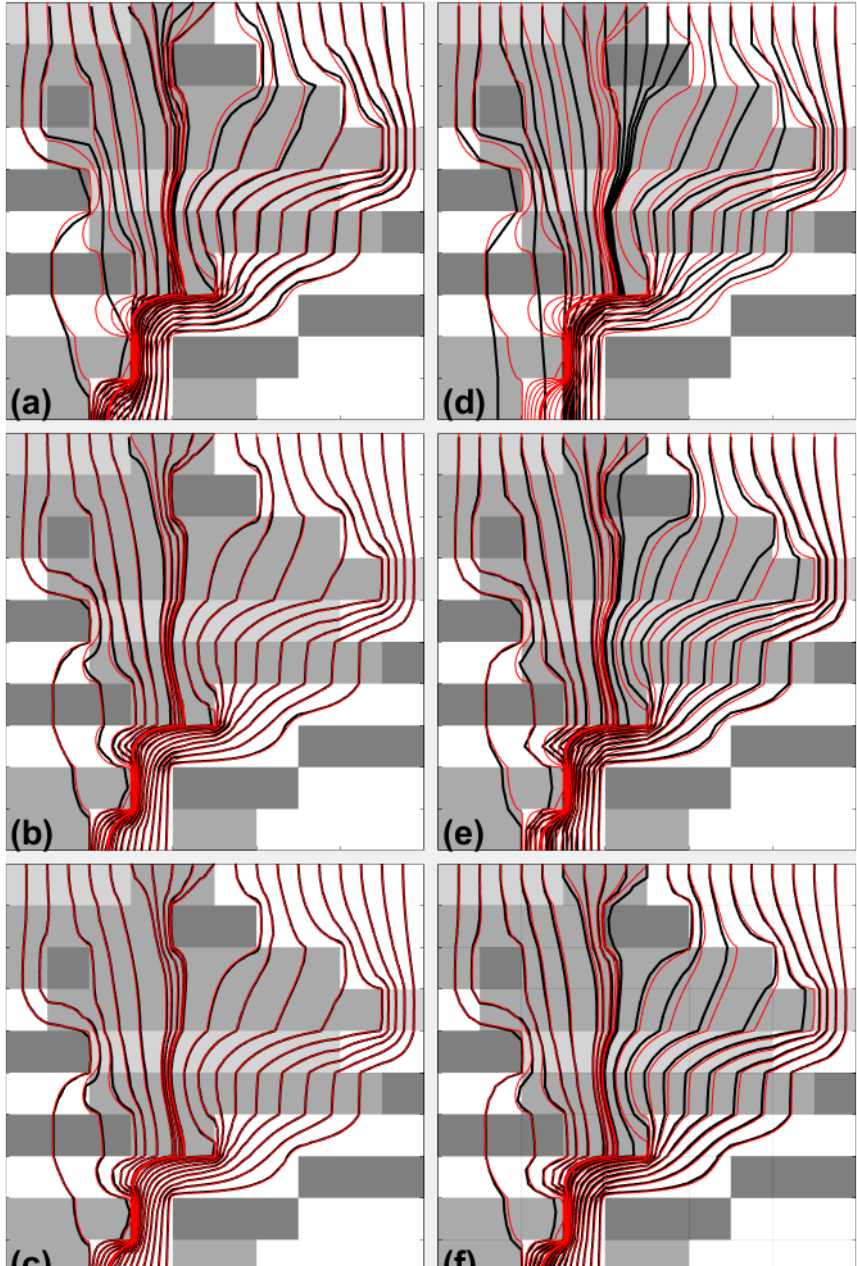
Figure 5. Simulated path lines (black lines) with both the MHFEM code HydroTec © and the finite- difference-based MODFLOW/MODPATH codes are presented in the first ( a – c ) and second columns ( d – f ), respectively, and for the 10 × 10, 20 × 20, and 30 × 30 grid resolutions starting from the top. The reference path lines (red lines) are computed using a mixed approximation with a 320 × 320 grid resolution. The MHFEM approximation yields a more accurate solution at a 20 × 20 resolution ( b ) than a finite difference approximation at a higher resolution ( f ).